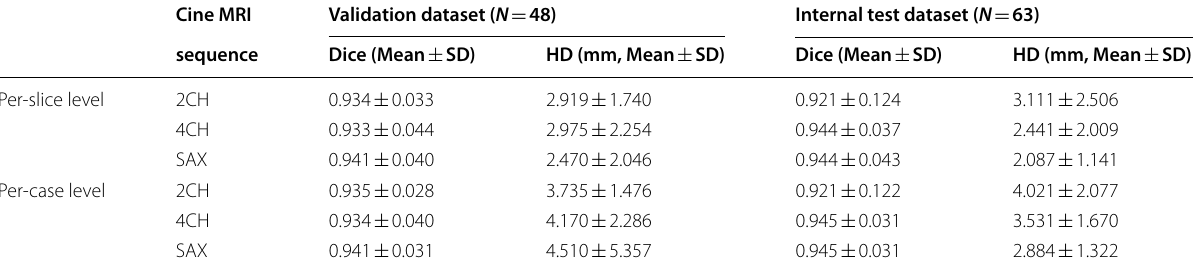
2CH—two-chamber, 4CH—four-chamber, SAX—short axis, HD—Hausdorff distance, SD—standard